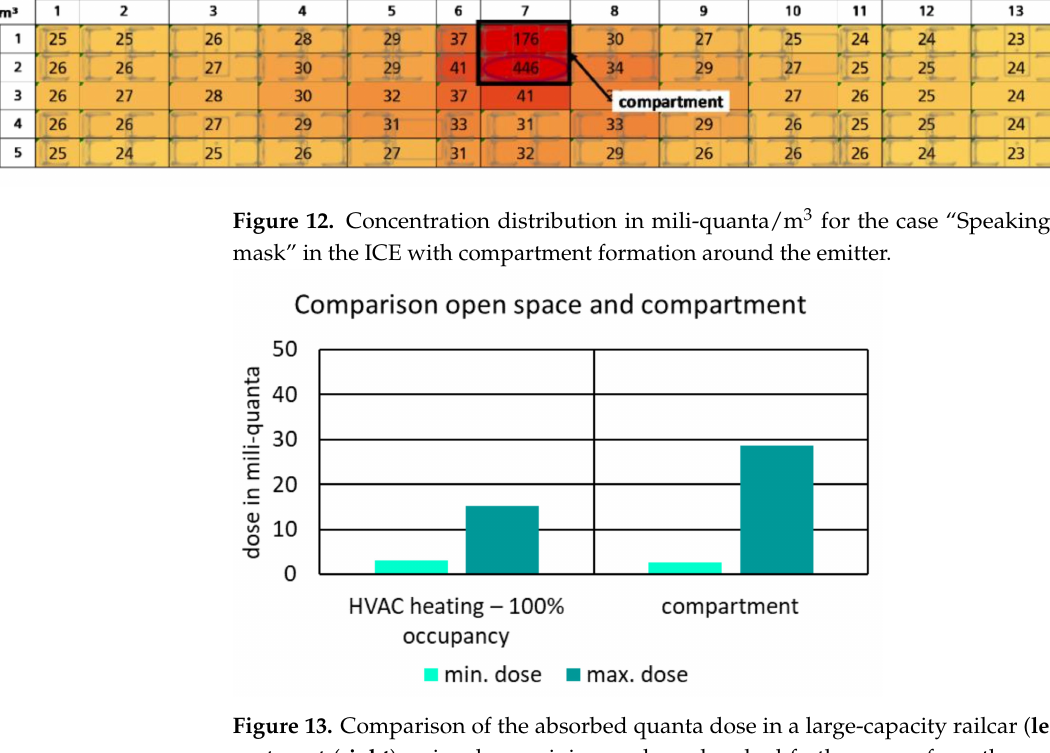
Figure 13. Comparison of the absorbed quanta dose in a large-capacity railcar ( left ) versus a com- partment ( right ): min. dose, minimum dose absorbed farther away from the emitter; max. dose, maximum exposure that is absorbed close to the